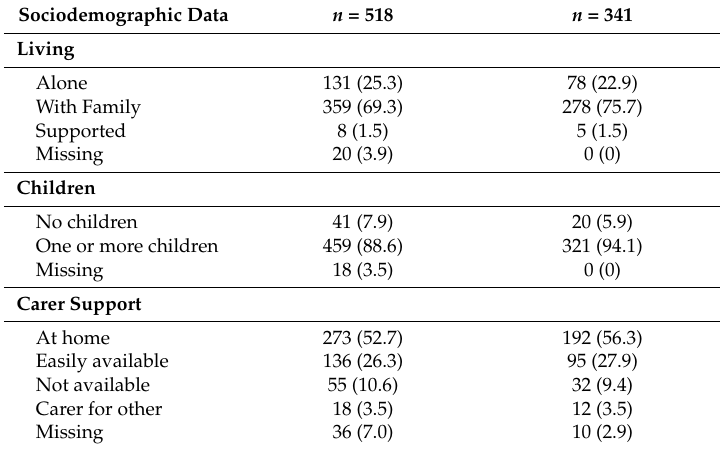
Table 2. Disease- and therapy-related data ( n = 518; n = 341 complete data sets included in regression analyses) All values are number (%) unless stated